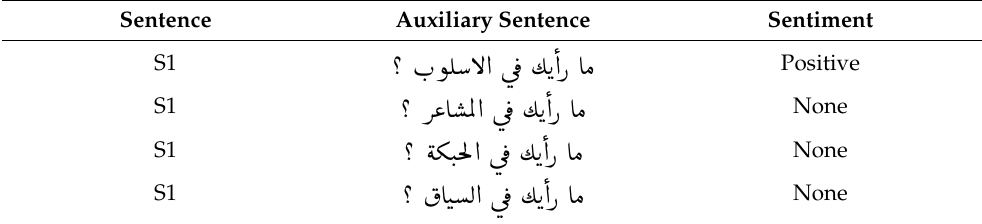
Table 2. An example of the HAAD dataset with the QA-M method for S1.